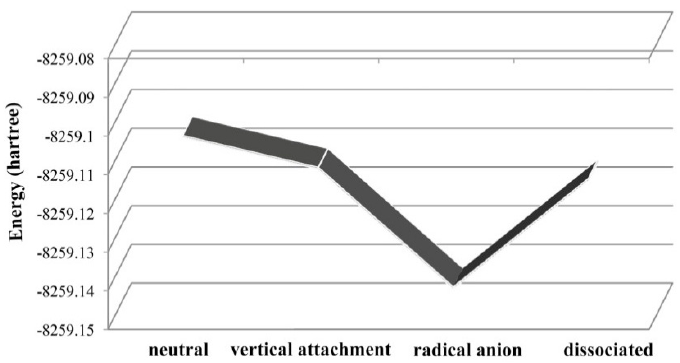
Figure 11. Reaction profile for electron-induced debromination of BDE-22 into the separated bromide anion and radical.